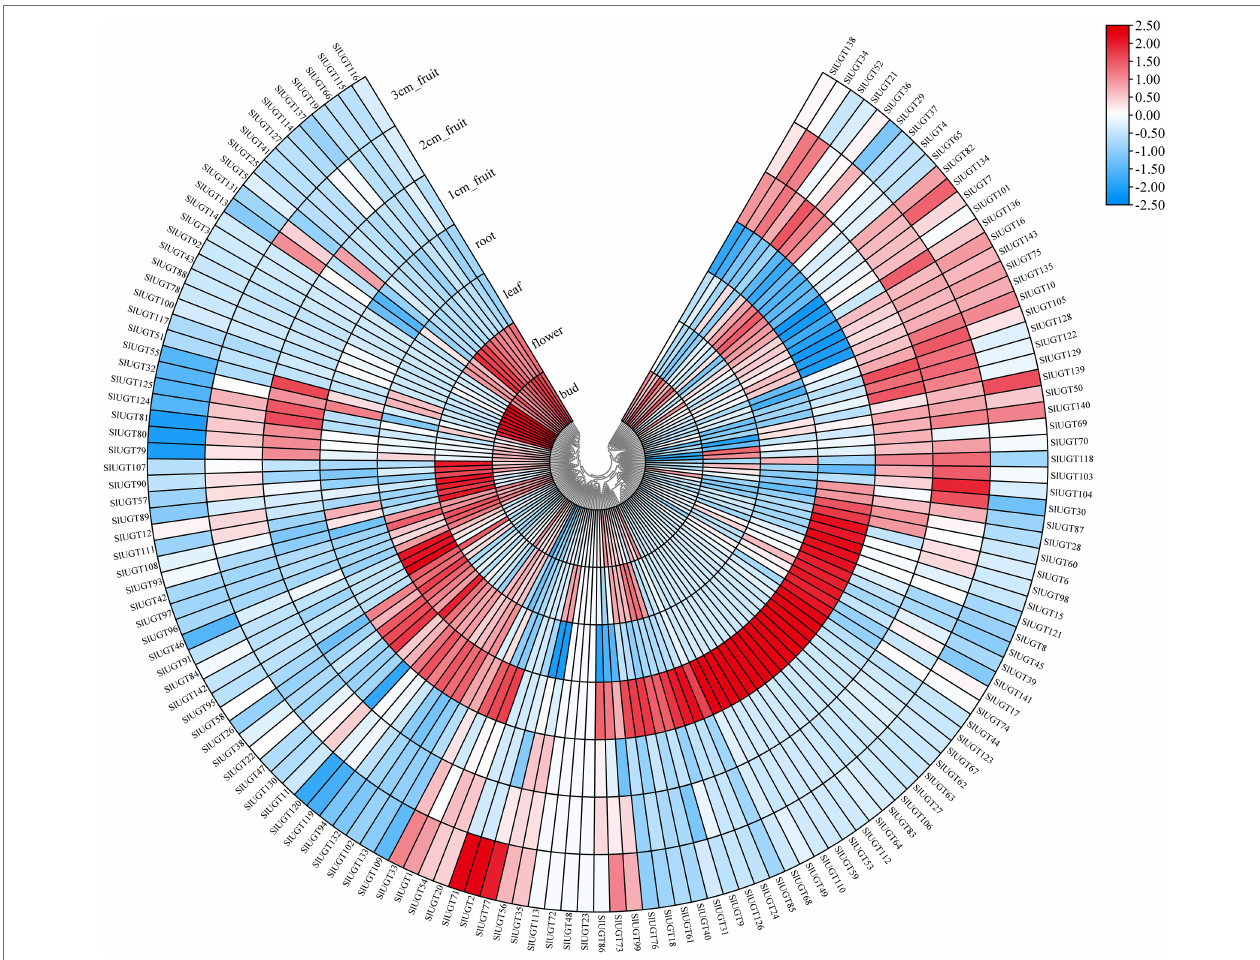
FIGURE 9 | Expression profiles of SlUGT genes in different tissues. The expression levels were based on the transcriptome data. All gene expression levels were log scaled by